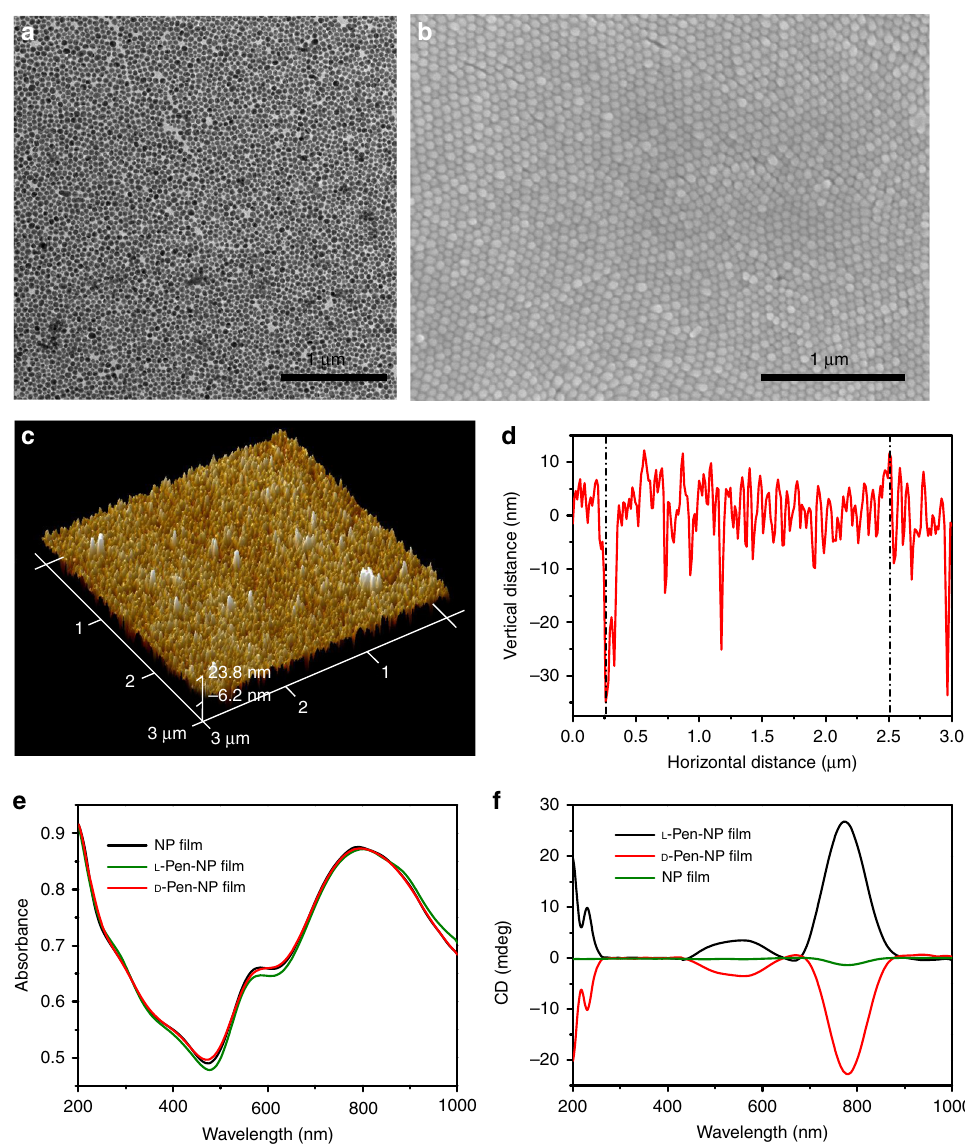
Fig. 2 Characteristics of Au NP fi lms. a TEM images of Au NP fi lm. b SEM images of Au NP fi lm. c AFM 3D image of Au NP fi lm. d Vertical distance of Au NP fi lm. e UV – Vis spectra of Au NP fi lm and L / D -Pen modi fi ed Au NP fi lm. f CD spectra of Au NP fi lm and L / D -Pen modi fi ed Au NP fi lm. The scale bars of TEM and SEM are 1 μ